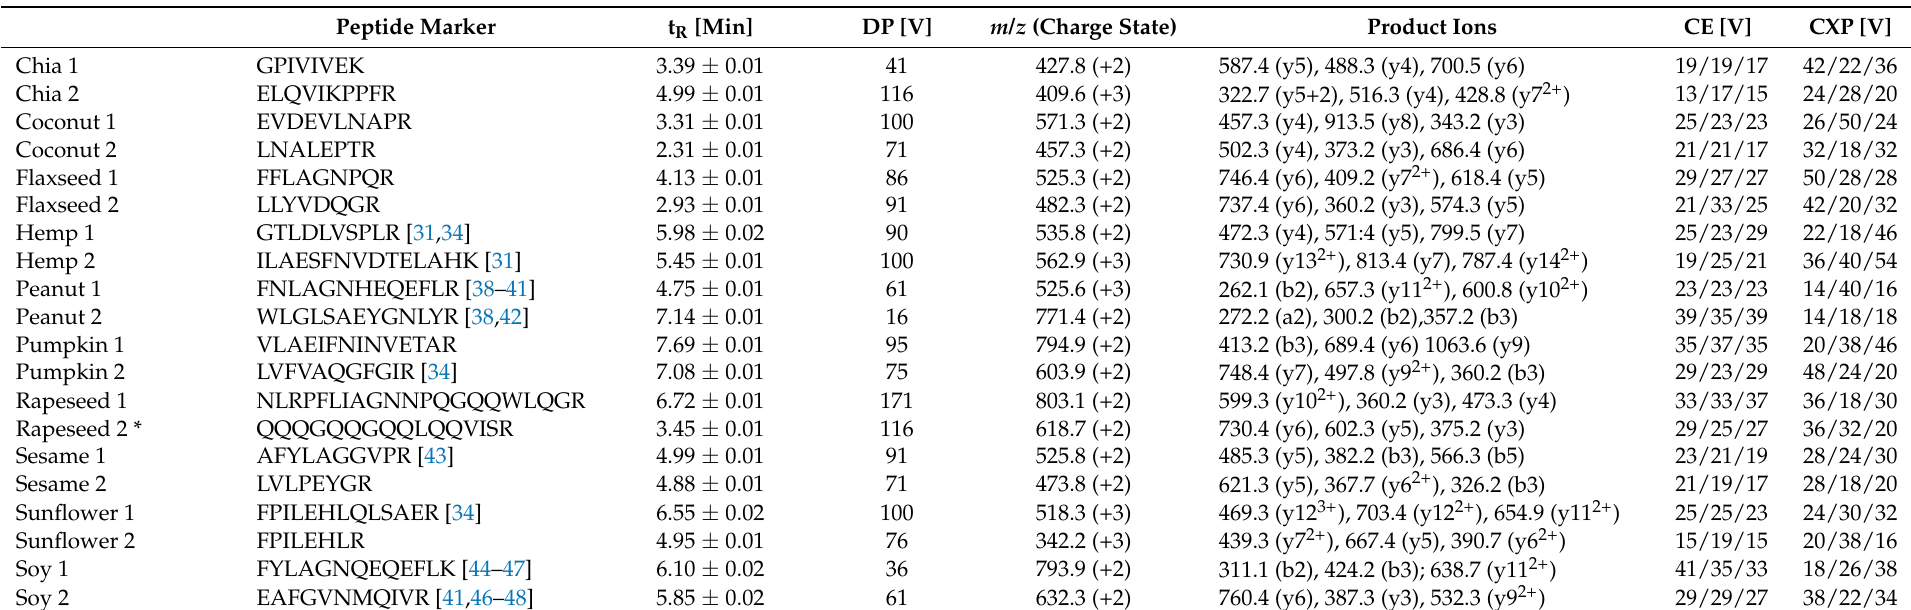
Table 2. Parameters of the scheduled MRM method (MRM detection window was set to 40s; CE = collision energy; CXP = cell exit potential; DP = declustering potential). The product ions are listed in decreasing intensity. Peptide 1 represents the quantifier, peptide 2 the qualifier (Section 3.2). * Homologies to mustard ( Brassica juncea , Brassica nigra , and Sinapis alba ) were detected